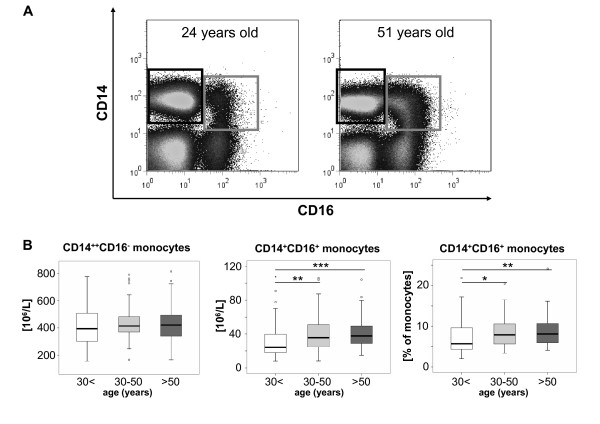
Age-dependent changes of circulating monocyte subsets. (A) Representative FACS plots display an increase of CD14+CD16+ monocytes (grey gate) in comparison to classical CD14++CD16- monocytes (black gate) among freshly isolated PBMC from old (right plot, 51 years-old male) versus young (left plot, 24 years-old female) volunteers. (B) Box plots display absolute numbers of circulating CD14++CD16- monocytes (left), CD14+CD16+ monocytes (middle) and the relative percentage of CD14+CD16+ from total monocytes (right) for the different groups of young (<30 years, n = 51), middle-aged (30-50 years, n = 70) and old (>50 years, n = 60) healthy volunteers. The bold black line indicates the median per group, the box represents 50% of the values, and horizontal lines show minimum and maximum values of the calculated non-outlier values; open circles indicate outlier values. Significant differences (Kruskal-Wallis and U-test) are marked by *p < 0.05, **p < 0.01 and ***p < 0.0015.